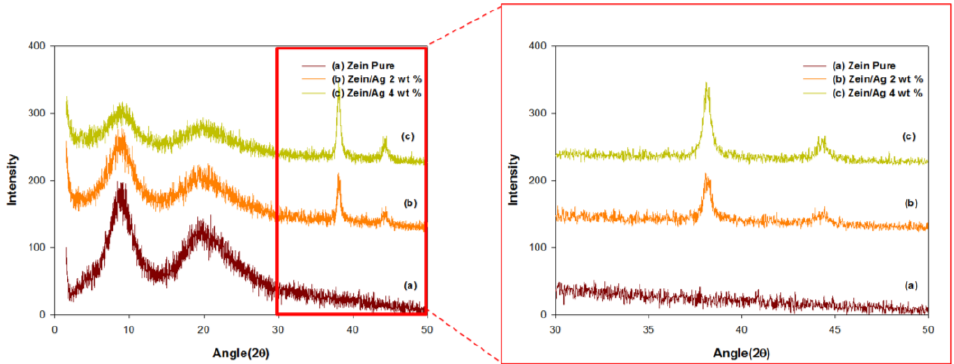
Figure 4. X-ray diffraction patterns of zein/Ag nanoparticles electrospun from ethanol aqueous solutions with an ethanol/water ratio of 8/2 ( v/v ) at Ag concentrations of ( a ) 0, ( b ) 2 and ( c ) 4 wt % (polymer concentration = 10 wt %, TCD = 15 cm, and applied voltage = 15 kV).